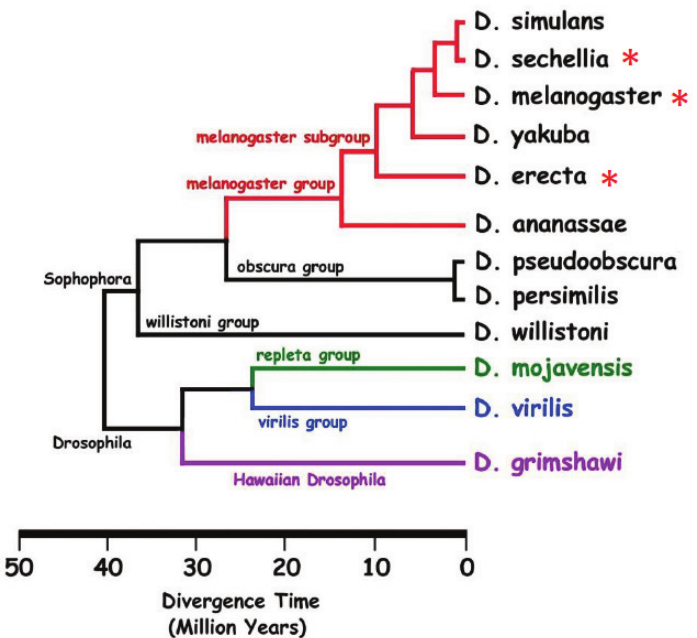
Figure 3. Phylogenetic relationship between different Drosophila species cited in the text. Red asterisks show the species that present qualitative sex cuticular hydrocarbon